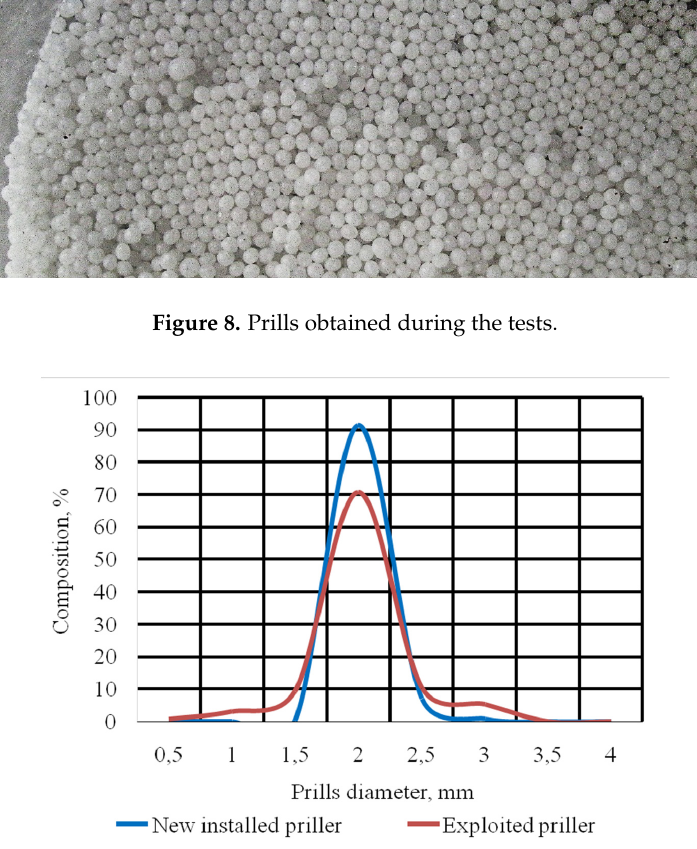
Figure 9. Comparison of size distributions of ammonium nitrate prills.